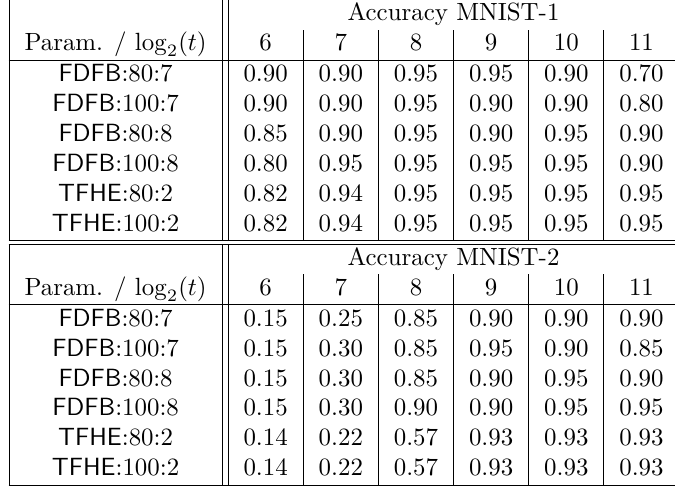
Table 8: Accuracy for homomorphic evaluation of the neural networks. For accuracy we show values for f = ReLU , but stress that we can use arbitrary univariate functions without impacting execution time. We discretized the models using a discretiza- tion factor δ = 6 for MNIST-1- f and δ = 4 for MNIST-2- f .